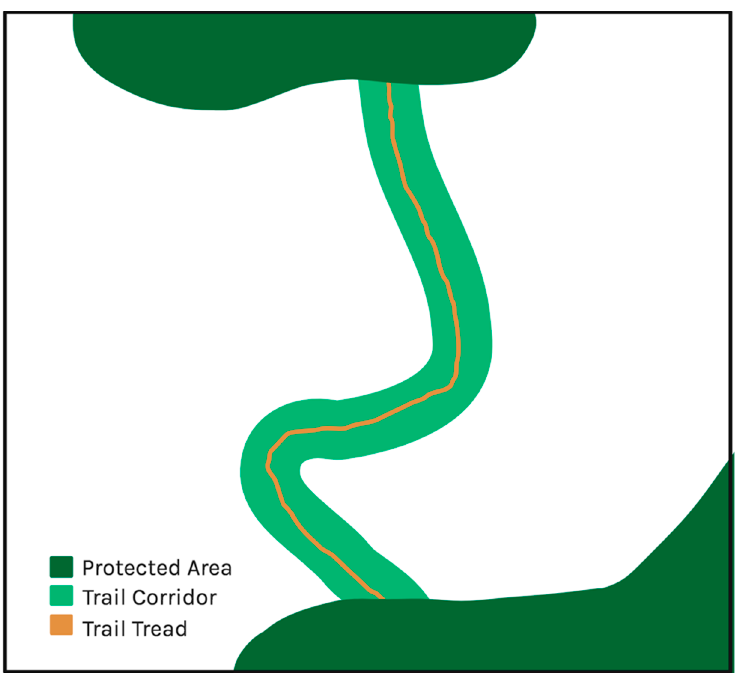
Figure 1. Diagram of a trail tread versus a trail corridor.